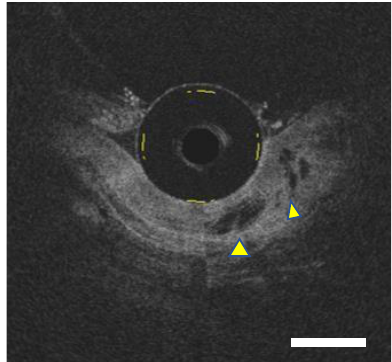
Figure 1. Representative images of probe-type optical coherence tomography (OCT). OCT image (Bar, 1000 µ m): OCT images depicted dilated glandular components (yellow arrowhead) underneath the homogenous layer, indicating the existence of the buried Barrett’s glands overlaying the squamous epithelium.